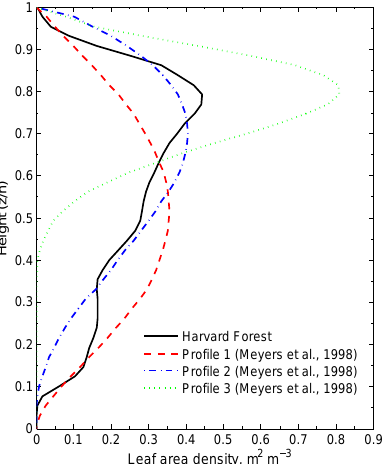
Figure 7. Vertical profiles of leaf area density in Harvard Forest and those used in sensitivity